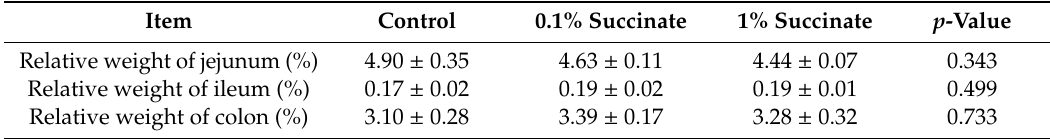
Table 3. Effects of diet sodium succinate supplementation on the intestinal index in growing pigs.